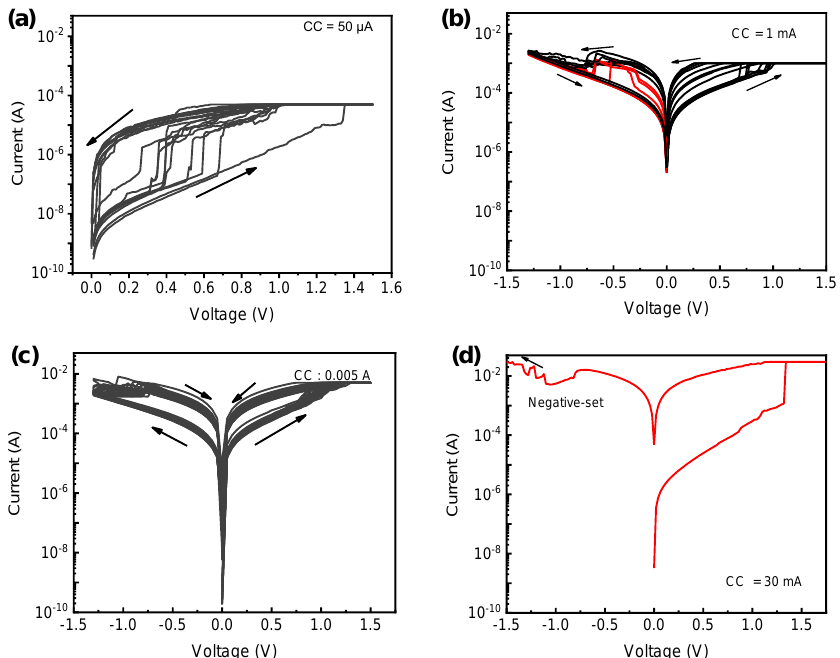
Figure 2. I-V characteristics of Ag/SnO x /TiN device with different compliance current conditions. ( a ) 50 µ A, ( b ) 1 mA, ( c ) 5 mA, ( d ) 30